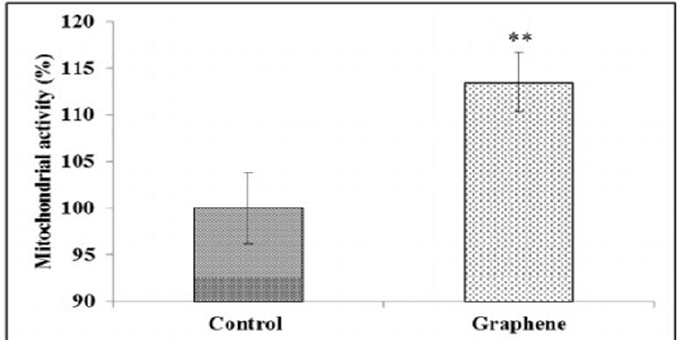
Figure 6. Mitochondrial activity (CCK-8 assay) of L929 fibroblasts grown on the glass and graphene substrates. Data are represented as mean ± SD (standard deviation) of three independent experiments.